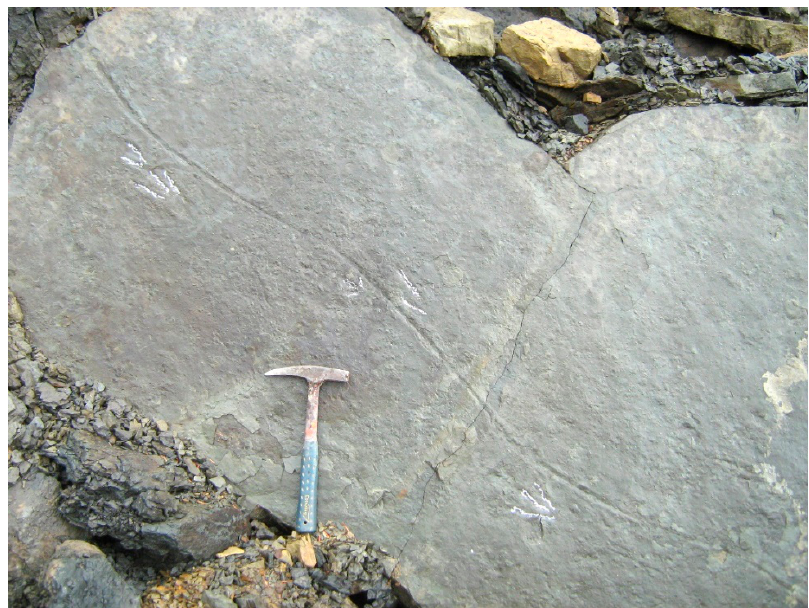
Figure 10. Crocodylian trackway preserving multiple footprints on either side of a prominent drag mark. Tracks are highlighted with chalk.